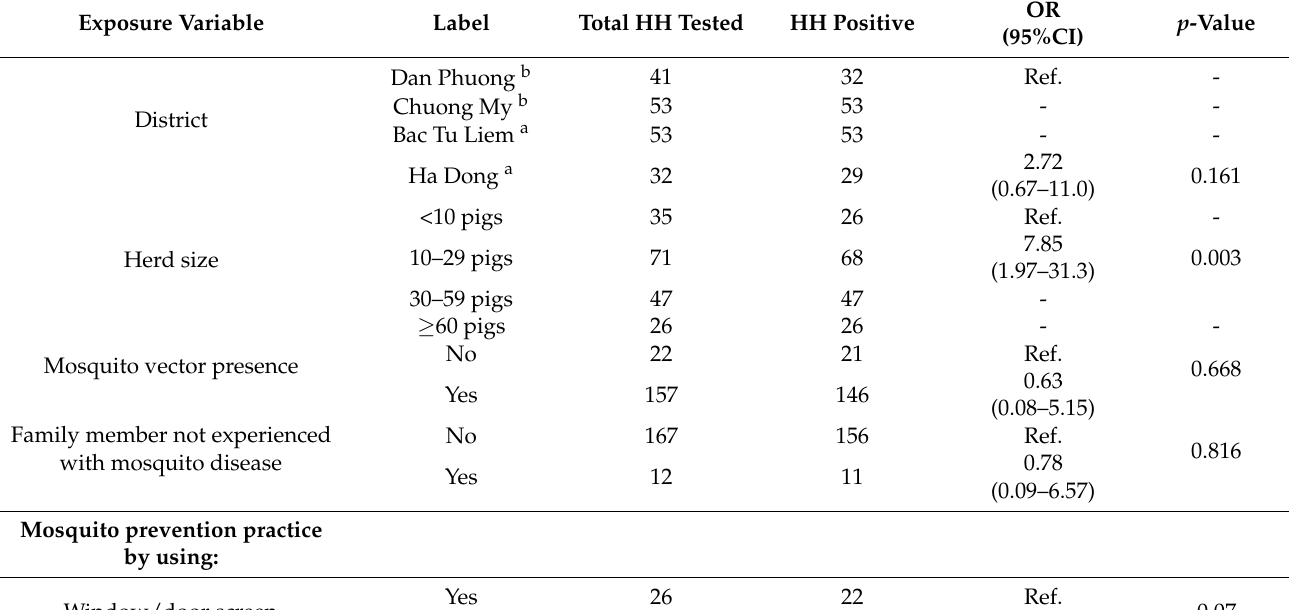
Table 11. Results from univariable analysis at farm